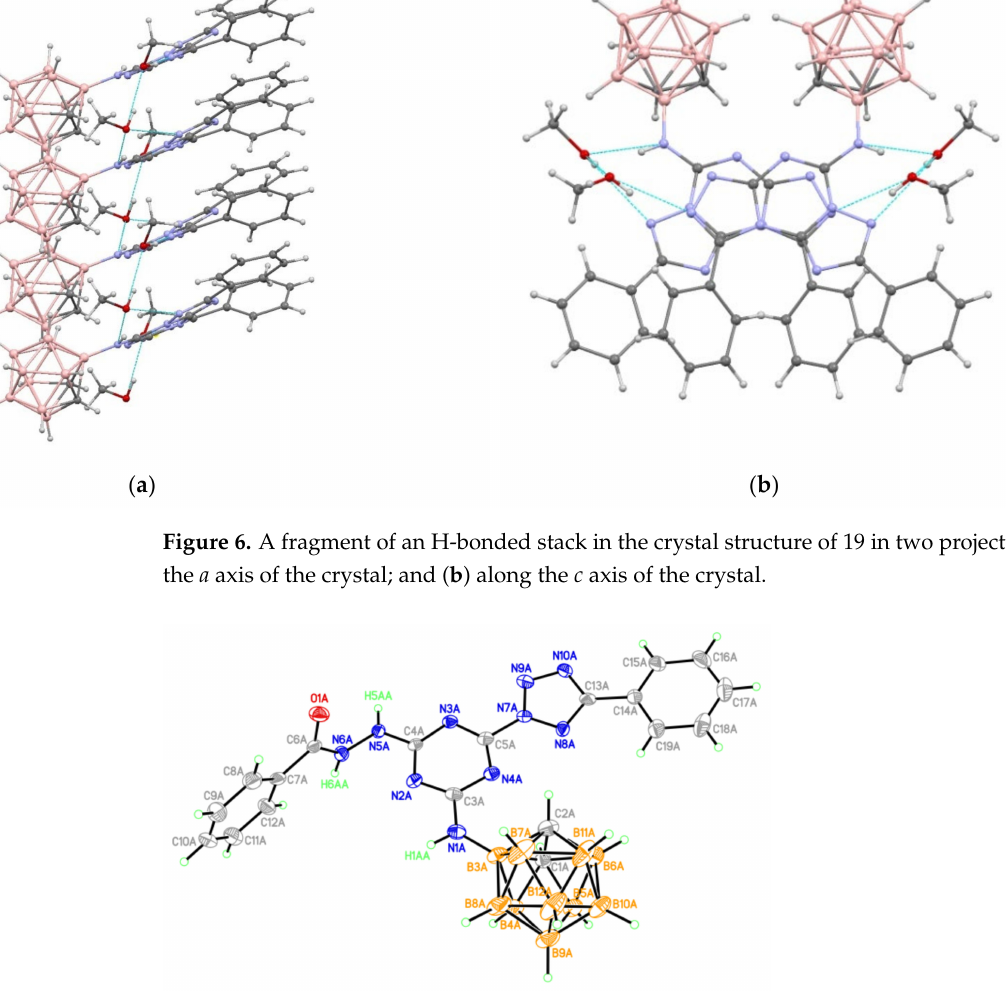
Figure 7. One of two crystallographically independent molecules (A) of compound 20 (thermal ellipsoids are drawn at the 50% probability